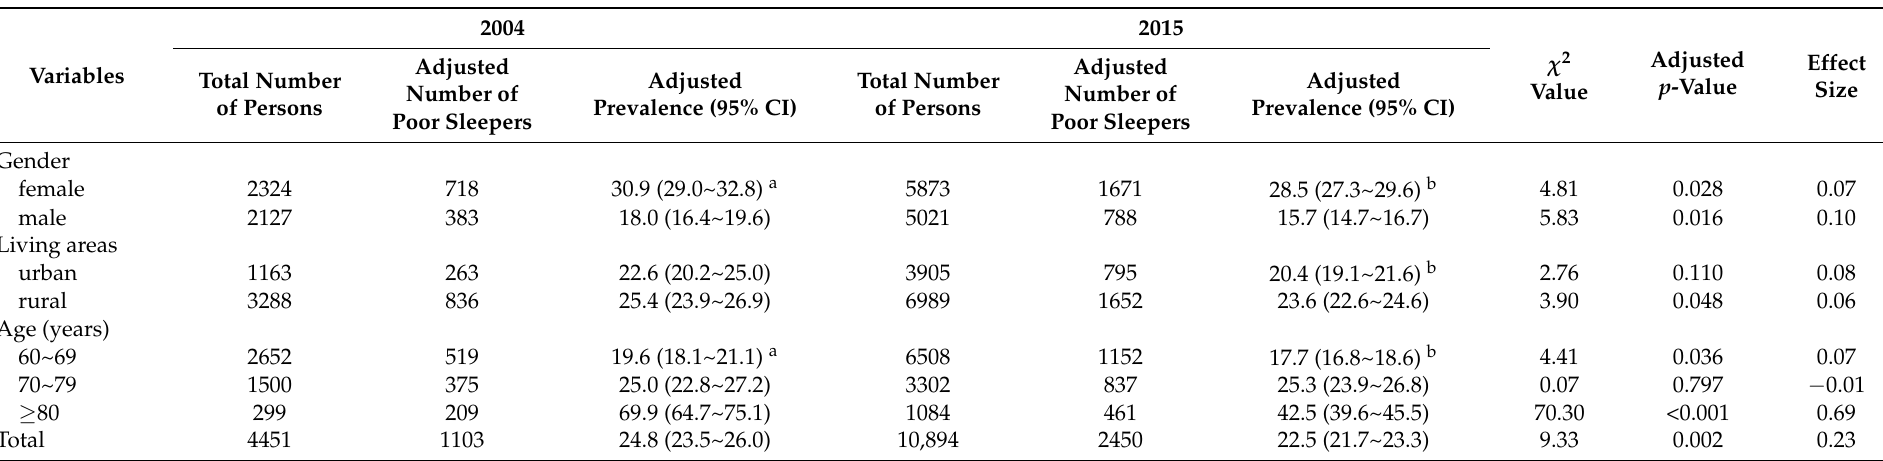
Table 3. Comparison of the 1-month prevalence of poor sleep between different populations aged ≥ 60 years in Shandong Province in 2004 and 2015 ( n ,